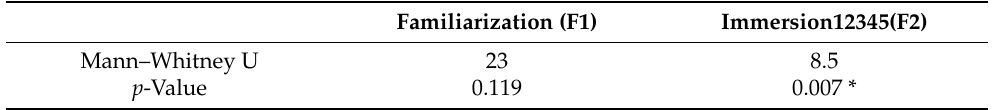
Table 4. Mann–Whitney U test